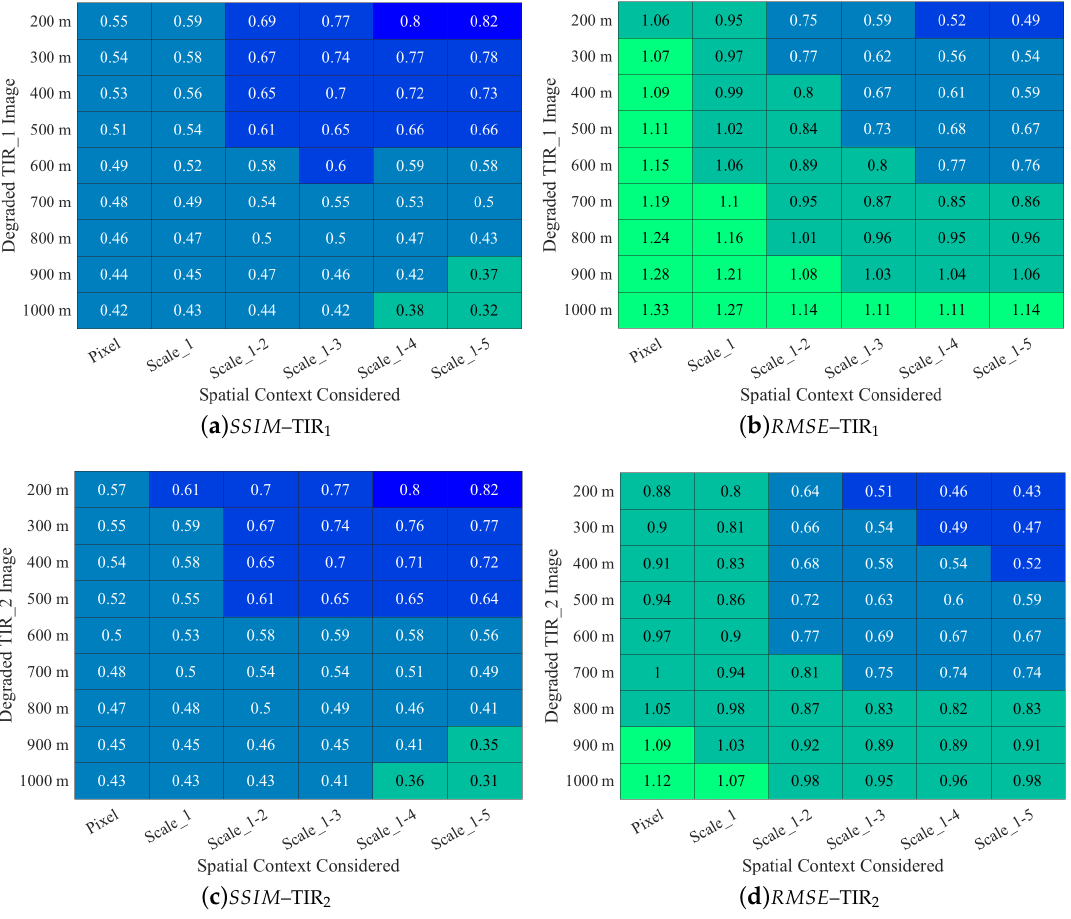
Figure 6. Heatmaps of SSIM ( a , c ) and RMSE ( b , d ) indices comparing the original TIR images (100 m) and the sharpened TIR, obtained by TS 2 uRF, from degraded images and considering different spatial context